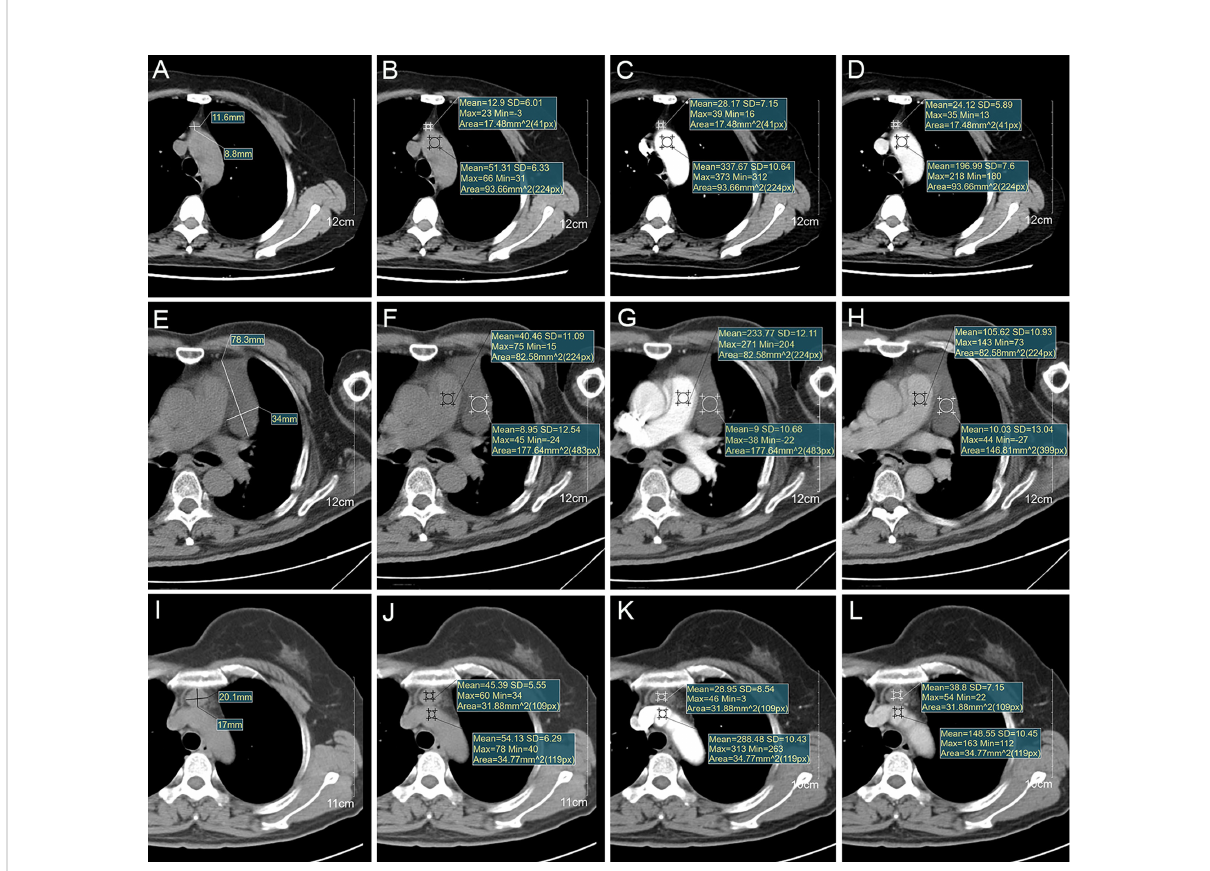
FIGURE 1 (A-D) Images of a thymic cyst with increased postcontrast attenuation values on CE-CT in 62-year-old woman (age in 2018). Imaging shows (A) a thymic cyst measuring 11.6×8.8 mm, (B) 12.9HU with aortic arch measuring 51.3HU on nonenhanced CT, (C) 28.2HU with aortic arch measuring 337.7HU on arterial phase, and (D) 24.1HU with aortic arch measuring 197.0HU on venous phase of CE-CT. (E-H) Images of a thymic cyst with stable postcontrast attenuation values on CE-CT in 65-year-old man (age in 2017). Imaging shows (E) a thymic cyst measuring 78.3×34 mm, (F) 9.0HU with main pulmonary artery measuring 40.5HU on nonenhanced CT, (G) 9.0HU with main pulmonary artery measuring 233.8HU on arterial phase, and (H) 10.0HU with main pulmonary artery measuring 105.6HU on venous phase of CE-CT. (I-L) Images of a thymic cyst with decreased postcontrast attenuation values on CE-CT in 53-year-old woman (age in 2018). Imaging shows (I) a thymic cyst measuring 20.1×17.0 mm, (J) 45.4HU with brachiocephalic trunk measuring 54.1HU on nonenhanced CT, (K) 29.0HU with brachiocephalic trunk measuring 288.5HU on arterial phase, and (L) 38.8HU with brachiocephalic trunk measuring 148.6HU on venous phase of